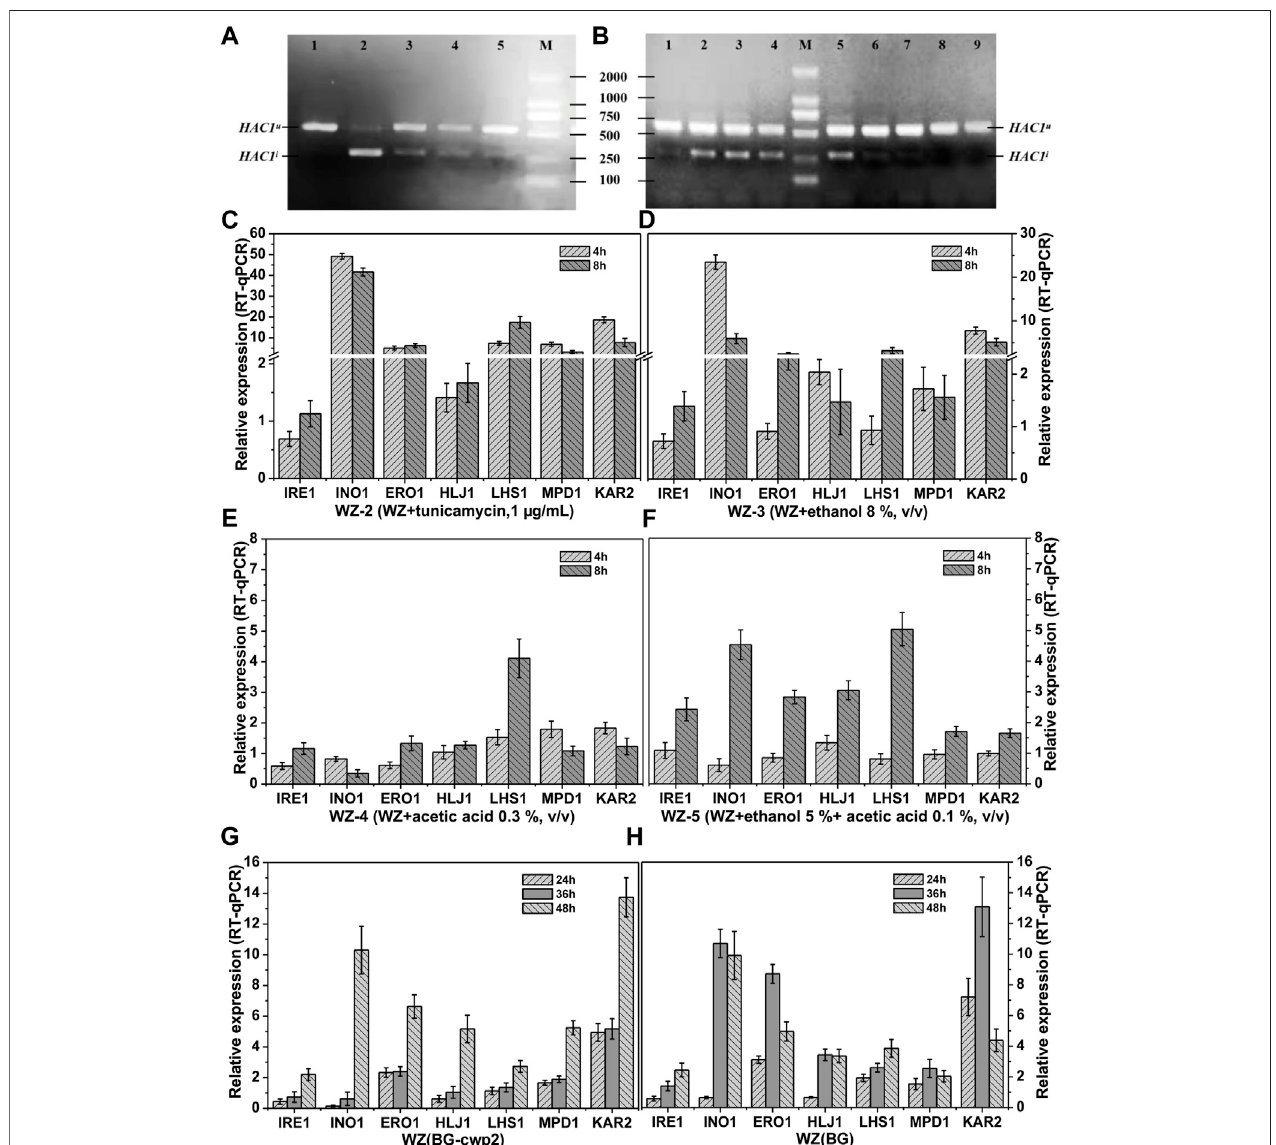
FIGURE 5 | HAC1 mRNA splicing and relative expression of UPR target genes. HAC1 mRNA splicing (A) and the relative expression level of UPR target genes (C – F) of strains WZ in YPD medium with different additives; HAC1 mRNA splicing (B) and relative expression level of UPR target genes (G – H) of strains WZ (BG-cwp2) and WZ(BG)in10%cellobiose. (A) lanes 1~5,WZ-1~WZ-5,8 h; (B) lanes1,8and9,24,36and 48 hfermentation timeofstrainWZ(YEplac195);lanes 2~4,24,36and 48 h fermentation time of strain WZ (BG); lanes 5~7, 24, 36 and 48 h fermentation time of strain WZ (BG-cwp2). Each data point was referred to the control strain samples, and the mRNA levels of the target genes were determined by qPCR after normalization with constitutive control ACT1 gene. The results represent the average and standard deviation of three independent biological replicates. The original data was shown in Supplementary Material Table 4 .